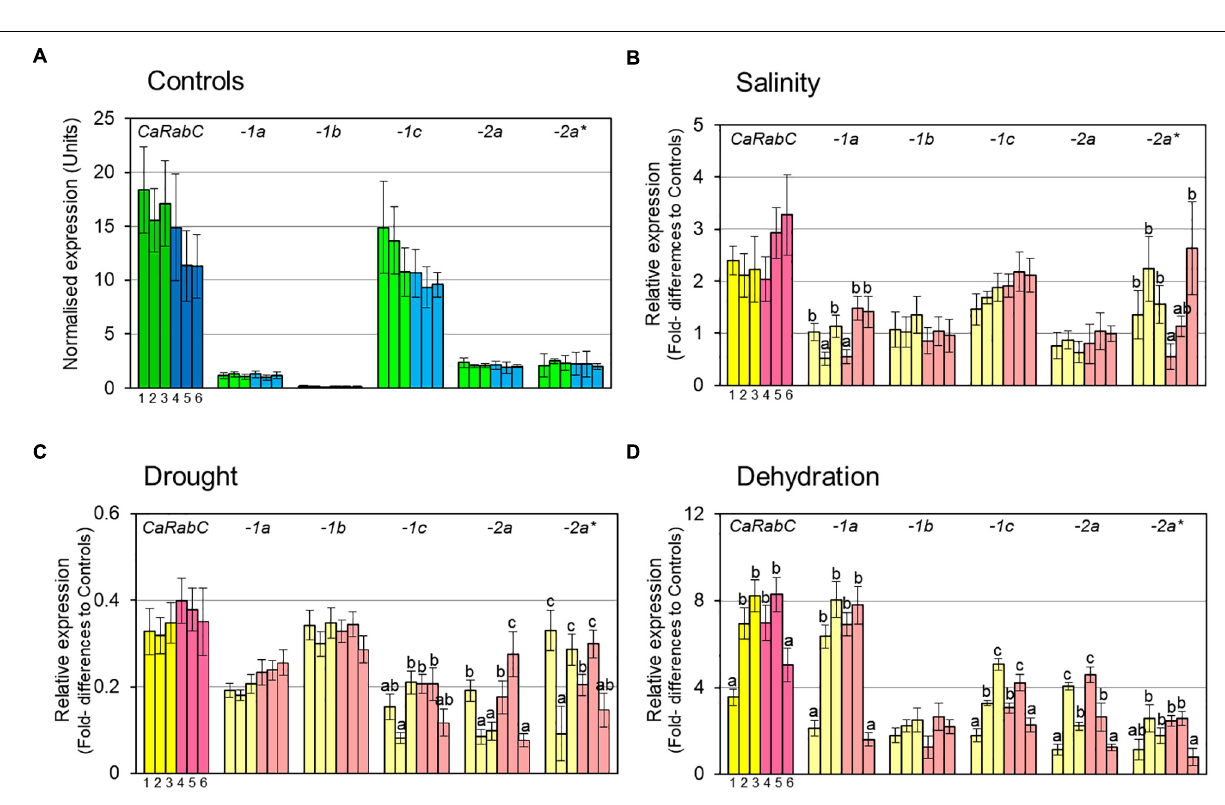
Frontiers in Genetics |